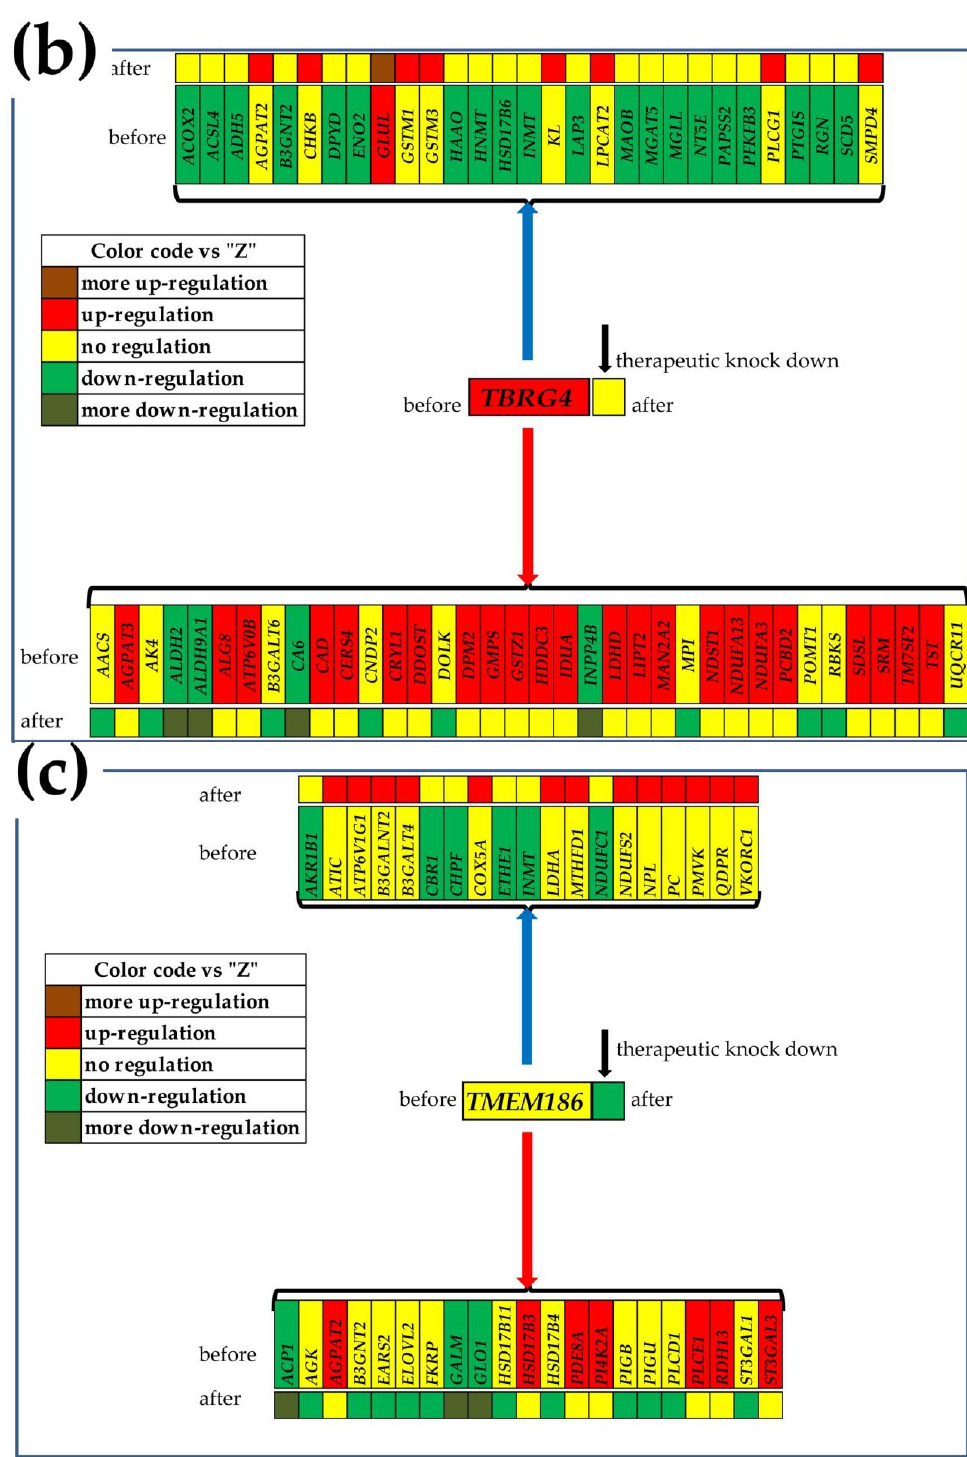
Figure 5. Significantly synergistically and antagonistically expressed metabolic genes with the corresponding GMR in the nodules ( a ) “P”, ( b ) “Q” and ( c ) “M” of the “PQMZ” patient and the predicted regulations after the therapeutic alteration of the GMR. The red/blue arrow indicates the genes synergistically/antagonistically expressed with the GMR in that nodule. Gene symbol background indicates the status of that gene in the mentioned cancer nodule with respect to the surrounding normal tissue “Z” before (observed) and after the treatment (predicted). Note the different regulations of the metabolic genes in the cancer